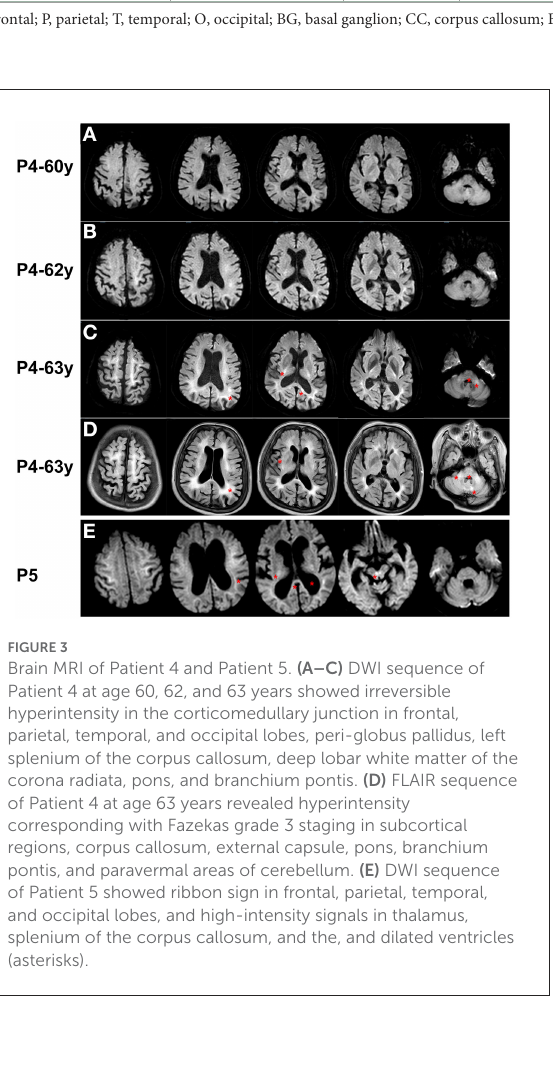
generalized cerebral and cerebellar atrophy. MR angiography showed no focal occlusion or